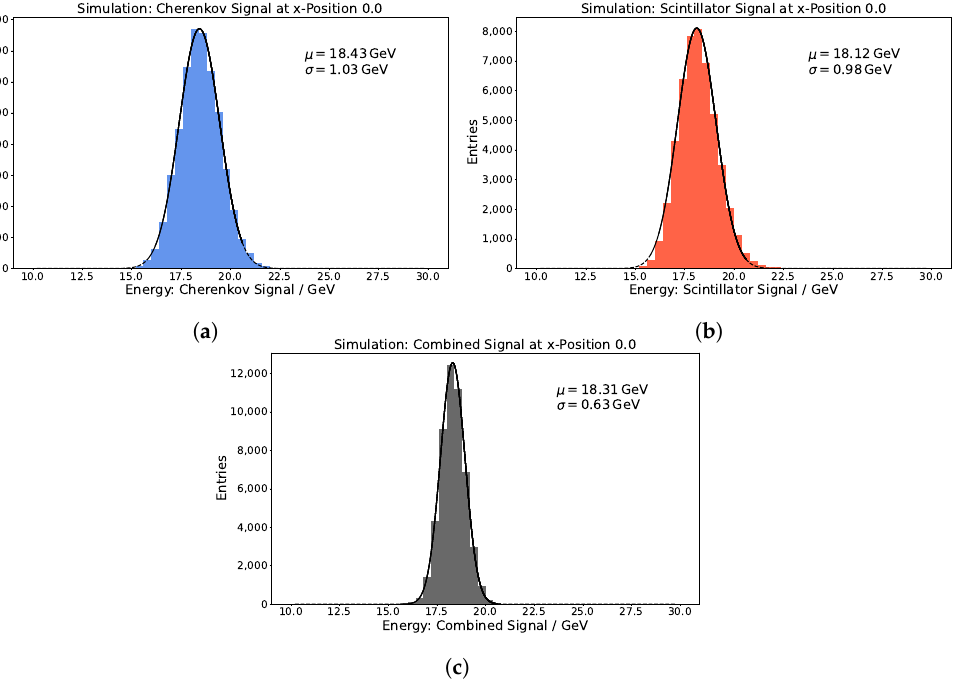
Figure 3. Energy deposit distributions for the ( a ) Cherenkov, ( b ) scintillation, and ( c ) combined channels. A Gaussian fit determines the peak position and width of the distribution, which later on is used to calculate the energy